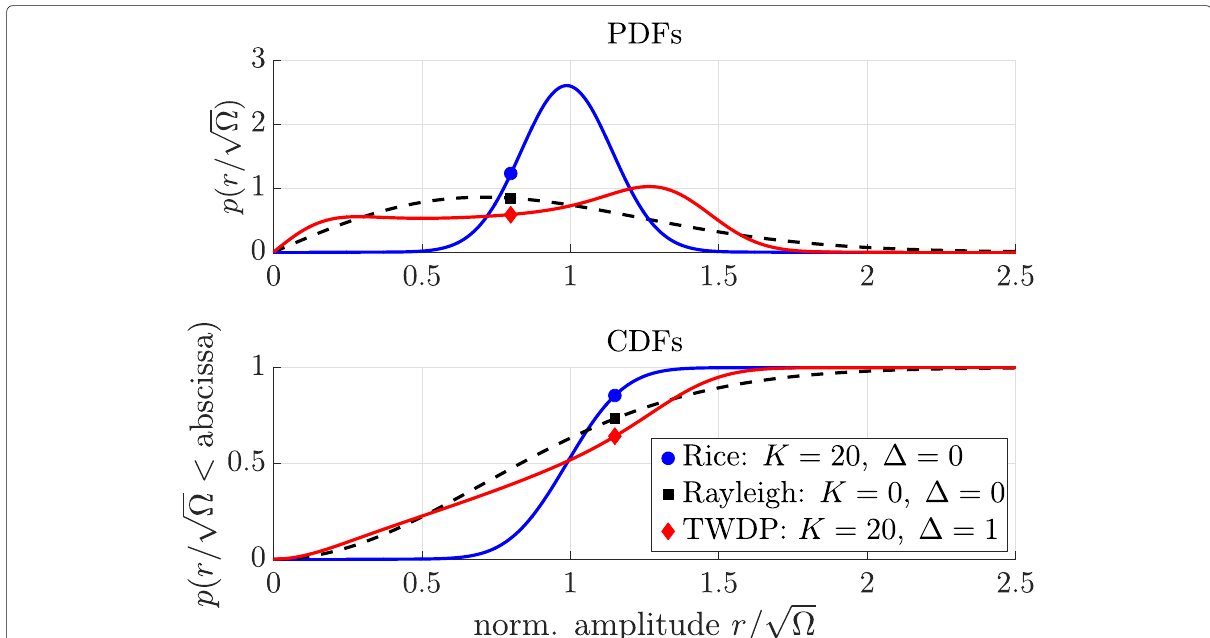
Fig. 1 Comparison of Rayleigh, Rician, and TWDP fading. The TWDP distribution with (cid:7) = 1 deviates from the Rice distribution. TWDP fading’s probability for deep fades is higher than for a Rayleigh distribution